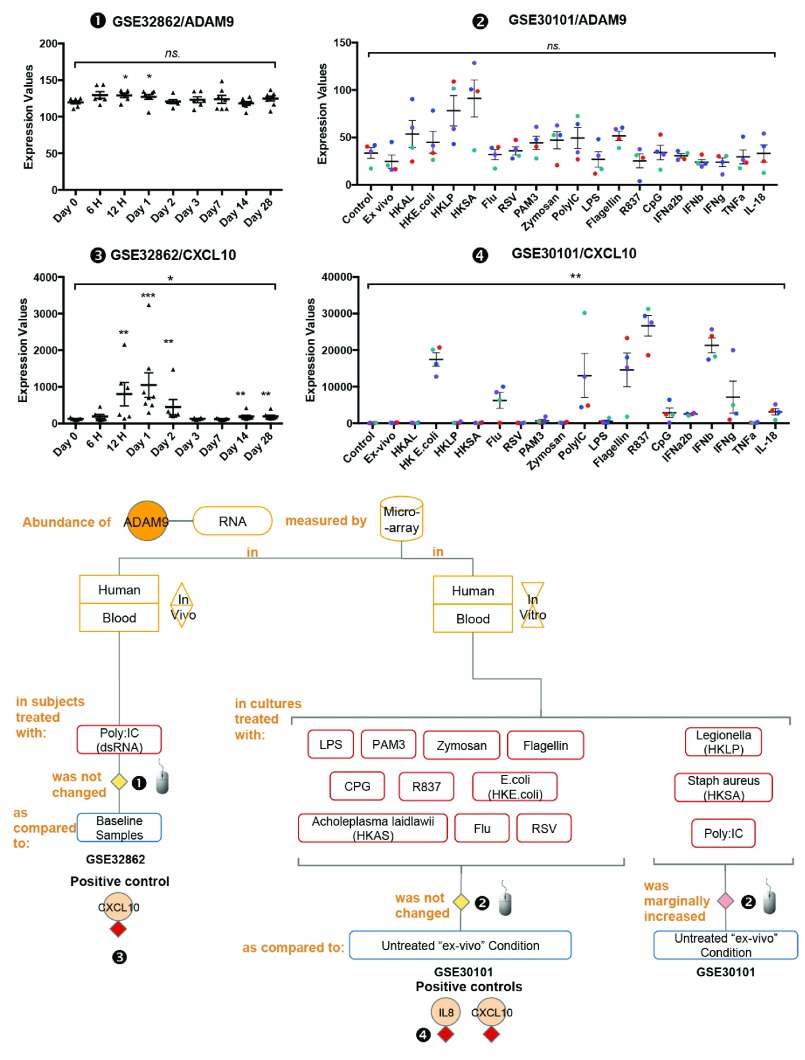
The abundance of ADAM9 increases only marginally following treatment with pathogen-associated molecules.mRNA expression levels for ADAM9 and CXCL10 were measured by microarrays in whole blood obtained from 8 healthy volunteers following sub-cutaneous administration of synthetic dsRNA (poly:IC) or placebo at baseline (day 0) and at 6 and 12 hours and 1, 2, 3, 7, 14, and 28 days (GSE32862), and from 4 healthy individuals(shown indifferent colors; Red, blue, green and purple) and stimulated
in vitro for 6 hours with a wide range of immune stimuli including PAM3, Zymosan, Poly IC, E-LPS, Flagellin, R837, CpG Type A, heat-killed
Legionella pneumophila (HKLP), heat-killed
Acholeplasma laidlawii (HKAL), and heat-killed
Staphylococcus aureus (HKSA); IL-18, TNF-α, IFN-α2b, IFN-β, IFN-γ; heat-killed
Escherichia coli (HKEC), live influenza A virus and live (GSE30101).The graphical legend represents visually the information associated with the public datasets used for the meta-interpretation of ADAM9 transcriptional profiles. The flow chart indicates how data were generated. Diamonds indicate availability of supporting data and in the interactive version are hyperlinked to context-rich interactive plots. Links to these plots are also provided below:❶
GSE32862 Whole blood was collected from 8 healthy volunteers following sub-cutaneous administration of synthetic dsRNA (poly:IC) or placebo at baseline (day 0) and at 6 and 12 hours and 1, 2, 3, 7, 14, and 28 days. As stated in the manuscript: “The study was approved by the Institutional Review Board of The Rockefeller University Hospital. Individual participants in this study provided written informed consent after appropriate review, discussion, and counseling by the clinical study team”
28.
https://gxb.benaroyaresearch.org/dm3/miniURL/view/Kd
❷
GSE30101 Blood was collected from four healthy individuals and stimulated
in vitro for 6 hours with a wide range of immune stimuli including PAM3, Zymosan, Poly IC, E-LPS, Flagellin, R837, CpG Type A, HKLP, HKAL, and HKSA; IL-18, TNF-α, IFN-α2b, IFN-β, IFN-γ; HKEC, live influenza A virus and live RSV. As stated in the manuscript: “The study was approved by the Baylor Research Institute Institutional Review Board at Baylor University Medical Center (Dallas, TX)”
27.
http://www.interactivefigures.com:80/dm3/miniURL/view/KB
❸ See description above.
https://gxb.benaroyaresearch.org/dm3/miniURL/view/Jr
❹ See description above.
http://www.interactivefigures.com:80/dm3/miniURL/view/Jw
Statistical significance was determined using one-way ANOVA and Dunnett’s multiple comparisons test.
ns, not significant, *
p < 0.05, ** p < 0.01, and ***
p < 0.001. The horizontal lines indicate mean ± standard errors (SE).